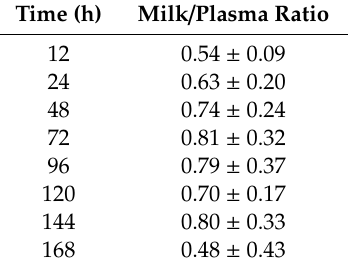
Table 2. Milk / plasma ratio (Mean ± SD) of oxytetracycline concentrations in cows ( n = 6) with clinical metritis after single intramuscular administration of 20 mg kg − 1 oxytetracycline hydrochloride as a long-acting drug formulation.